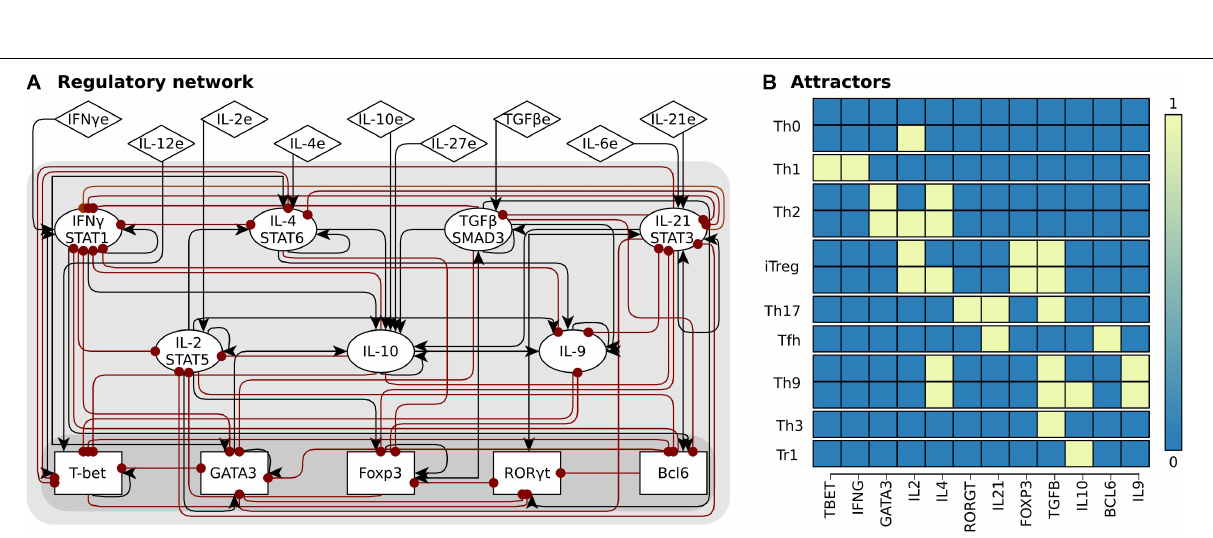
Frontiers in Physiology |